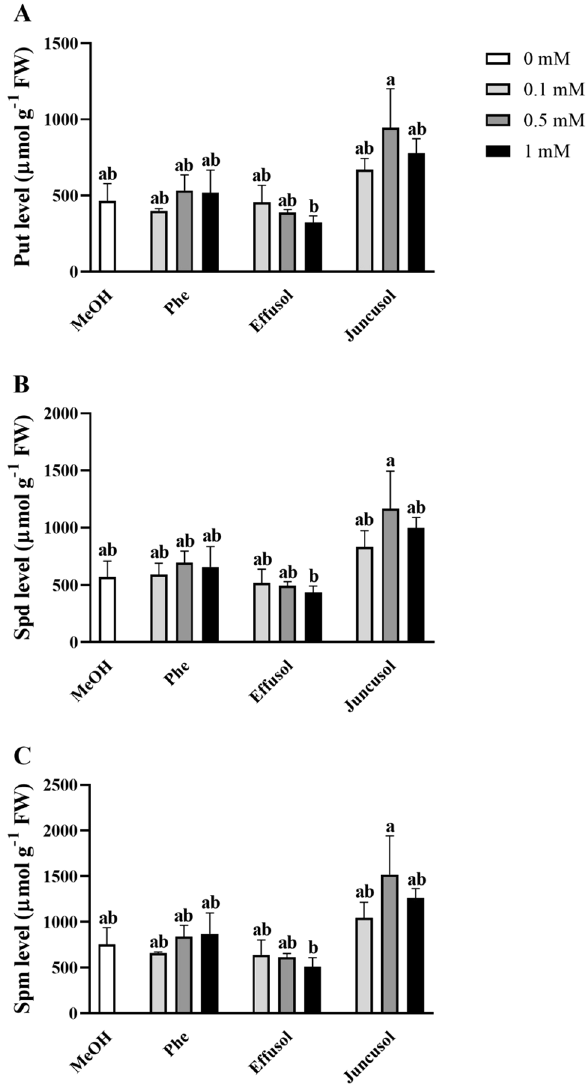
Figure 13. Free PAs (Put, Spd, and Spm) of seedlings treated with Phe, effusol and juncusol at different concentrations compared to MeOH. Data are presented as the mean ± SE (n = 3). Different letters indicate significant differences between the values of the treatments (P < 0.05) analysed by Tukey’s post-hoc test.